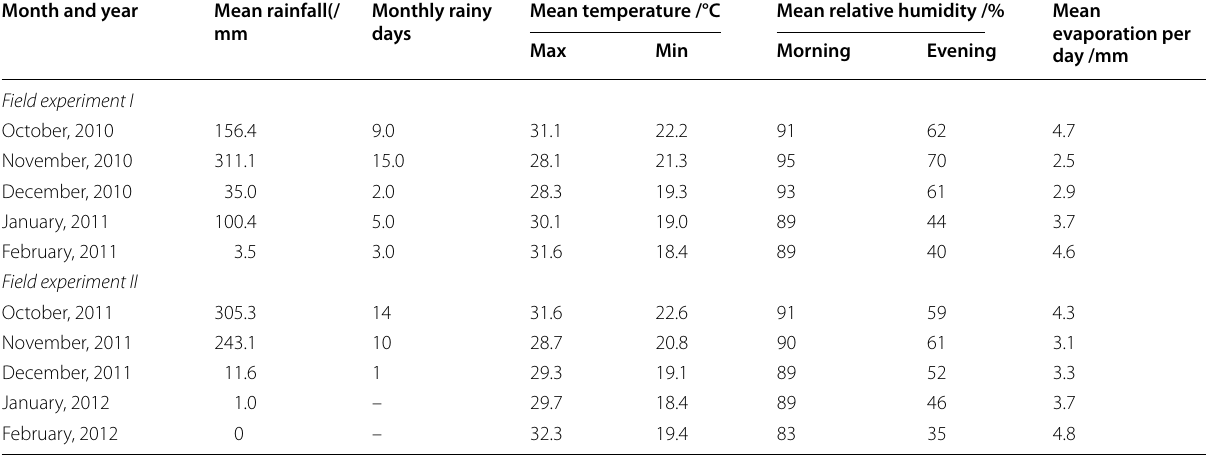
Table 1 Weather parameters recorded from the Observatory located 300 and 500 m distance from experimental field locations I and II during the trial execution